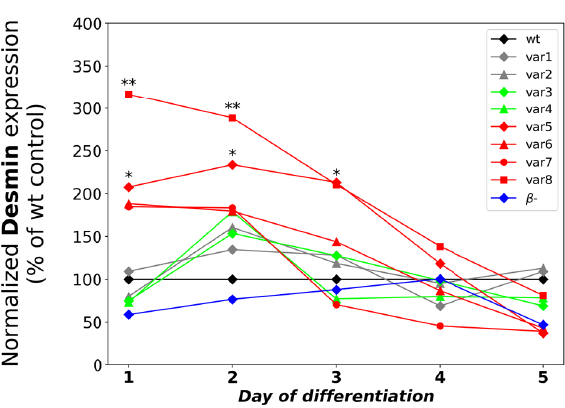
Fig. 3 | Differentiationprogress in the presenceofMef2D variants.a Early stage of myotube development (day 2 - day 4). The number of multinucleated, long myotubes in the presence of overexpressed Mef2D variants. Representative fl uor- escent and transmitted images represent randomly selected visual fi elds and were used to determine the fusion index of the appropriate cultures. Each experiment was independently repeated two times with similar results, at least 15 randomly selected visual fi elds were analysed. Scale bar is 50 µ m. b , c Protein expression of myogenic regulatory factors MyoD ( b ) and Desmin ( c ). Normalized protein expressionduringthedifferentiationofC2C12cells.Proteinexpressionwasplotted as a percentage of their wild-type control in each day of differentiation. Data was derived from quadruplicate measurements ( n =4 independent experiments),